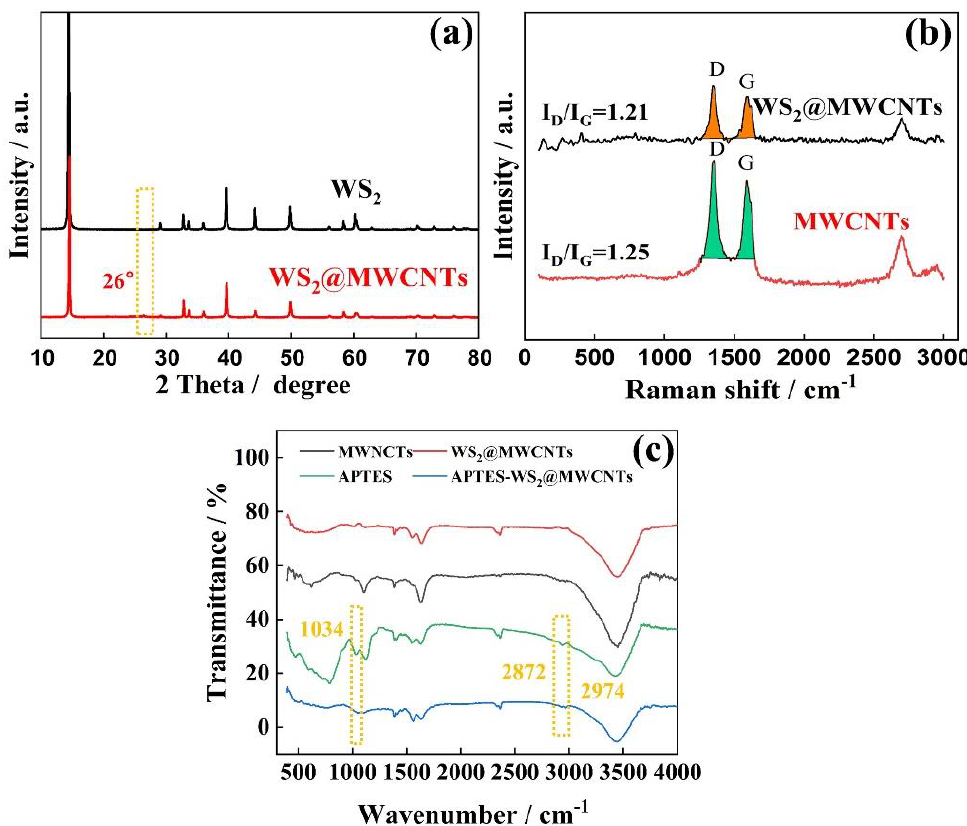
Figure 2. Basic characterization of nanoparticles. ( a ) XRD images of MWCNTs and WS 2 @MWCNTs, ( b ) Raman spectroscopy of WS 2 and WS 2 @MWCNTs, and ( c ) FTIR spectroscopy of